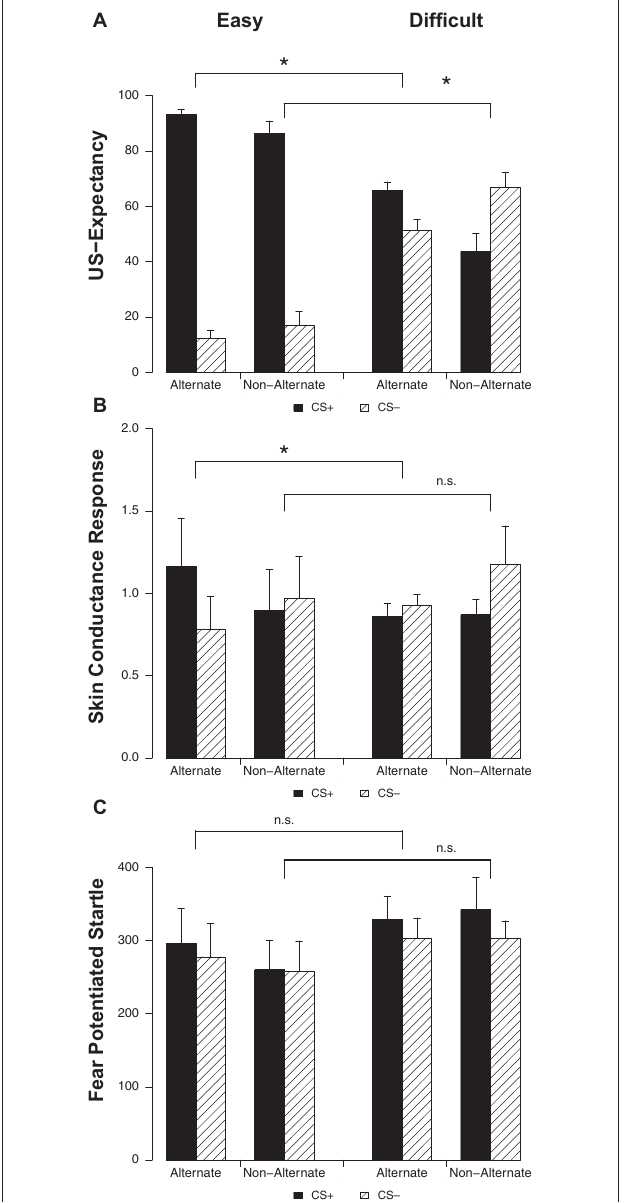
FIGURE 3 | US-expectancy ratings (A) , skin conductance responses (B) and startle responses (C) to the CS + and CS − on alternating and non-alternating trials for the Easy ( n = 16) and Difficult ( n = 18) conditions. Error bars represent s.e.m. * p < 0.05.